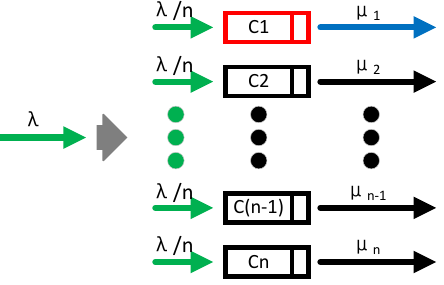
Figure 9. Coexistence capability analysis with n independent channels based on additive property of Possion-stream.